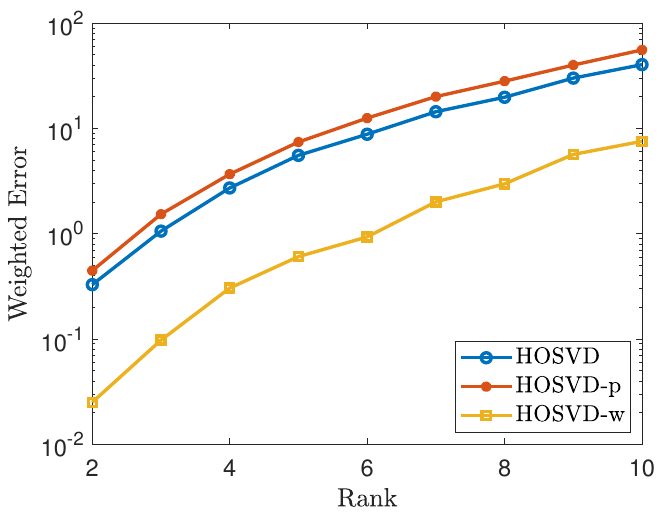
Figure 3. Tensor of size 100 × 100 × 100 using the non-uniform sampling pattern: plots the errors (cid:107)W ( 1/2 ) ( (cid:98) T −T ) (cid:107) F of the form . The lines labeled as HOSVD, HOSVD-p and HOSVD-w represent the (cid:26) (cid:107)W ( 1/2 ) (cid:107) F results for solving (4), (5) and (6), respectively.